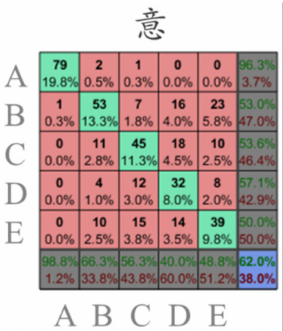
Figure 11. The results of a neural network test in which four subjects wrote the Chinese character in five different